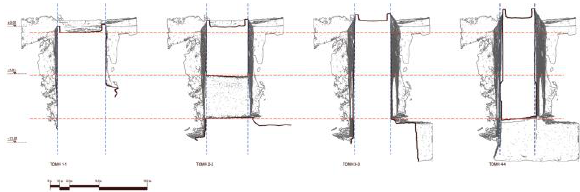
Figure 14. Plaka Bridge, West pillar plan, after the collapse. Figure 12. Sections of the remaining west pillar of the Bridge This almost automatic process ensures that the originally created directly from the 3D mesh. recorded 3D data is not distorted or modified by the user,